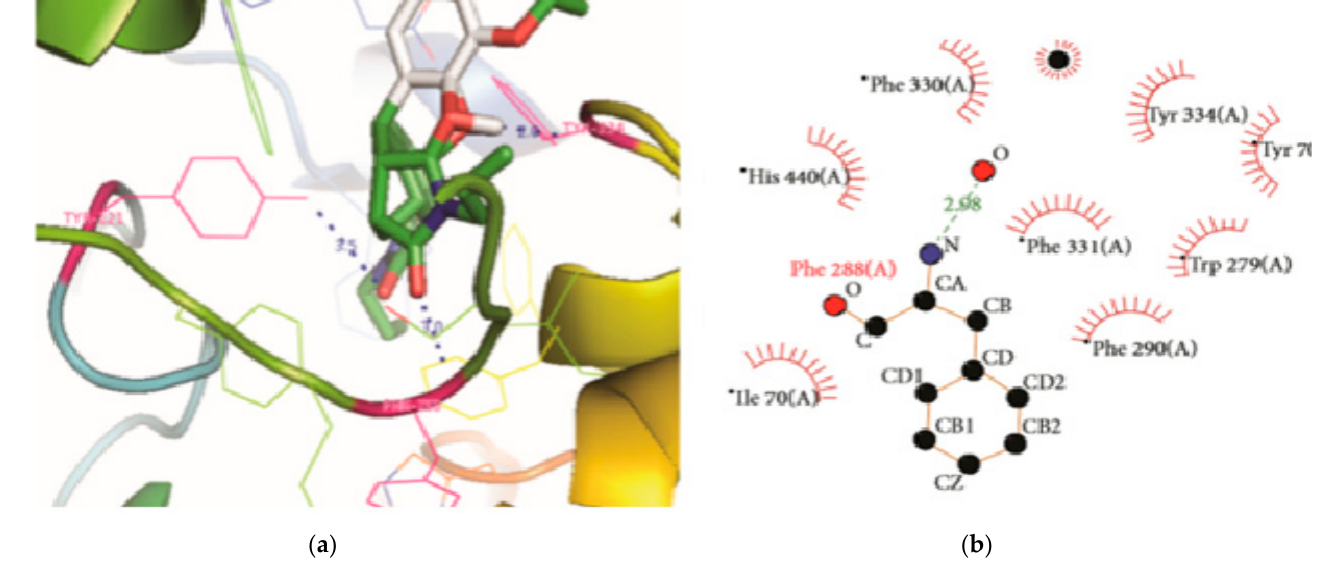
Figure 12. CALHM1 docking and Ligplot interaction with quercetin. ( a ) The hydrogen bond distance between the docked ligand and the active site is shown; ( b ) a two-dimensional depiction of a ligand and a protein residue.